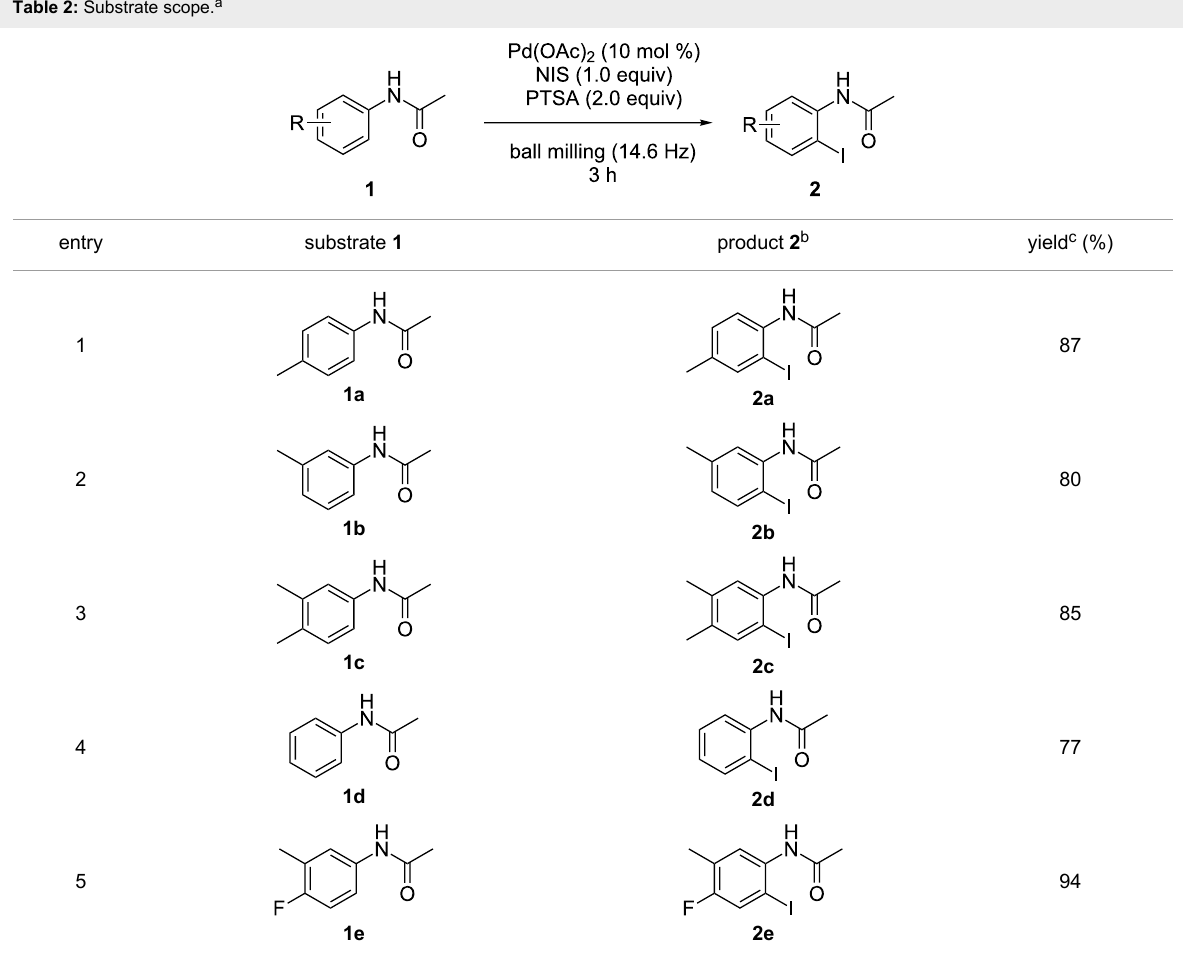
Table 2: Substrate scope.